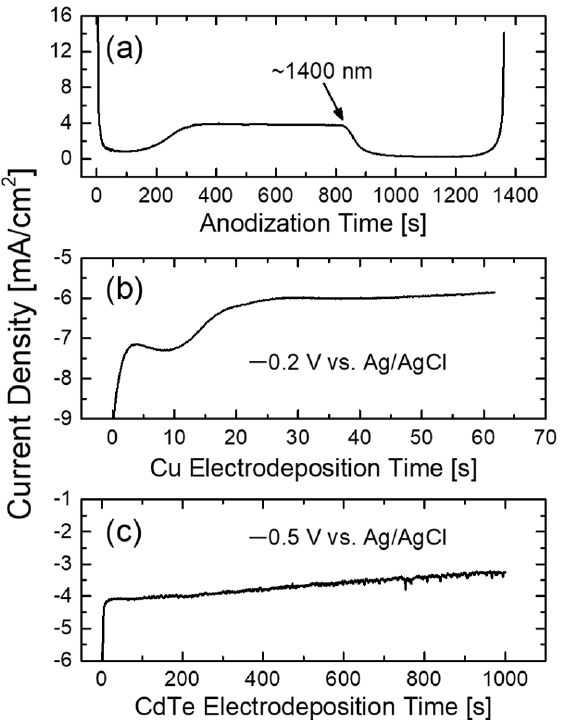
Figure 2. ( a ) Current curve acquired for the anodization of ∼ 1 µ m Al layer sputtered on the Au-coated Si substrate, leading to the formation of a supported AAO nanoporous template with a thickness of ∼ 1.4 µ m; ( b ) typical cathodic reduction current obtained during the electrochemical deposition of Cu NWs within the nanopores of the AAO template via application of − 0.2 V versus an Ag/AgCl reference electrode; ( c ) chronoamperometric electrodeposition curve corresponding to CdTe synthesis on top of the Cu NW array (after the complete removal of the AAO nanoporous host) while applying − 0.5 V versus an Ag/AgCl reference